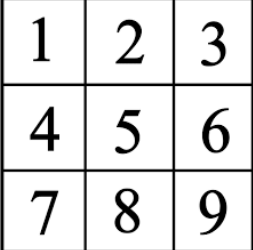
Figure 7. The 9-cell grid used for GRD determination After executing the flights, a data set of images for all three RGB cameras was obtained, containing the calibration target in every cell of the grid. Subsequently, by inspecting the data set, the findings concluded that when preserving the focal length of the cameras but changing the tilt of the cameras with a specific angle, the location of the best resolution (GRD) on the nadir camera is located in the image PPS (image middle) in the cell number 5 of the grid, while for the tilted cameras the location of the best resolution (GRD) is in the cell number 4 or 6, depending on the camera position (figure 8).